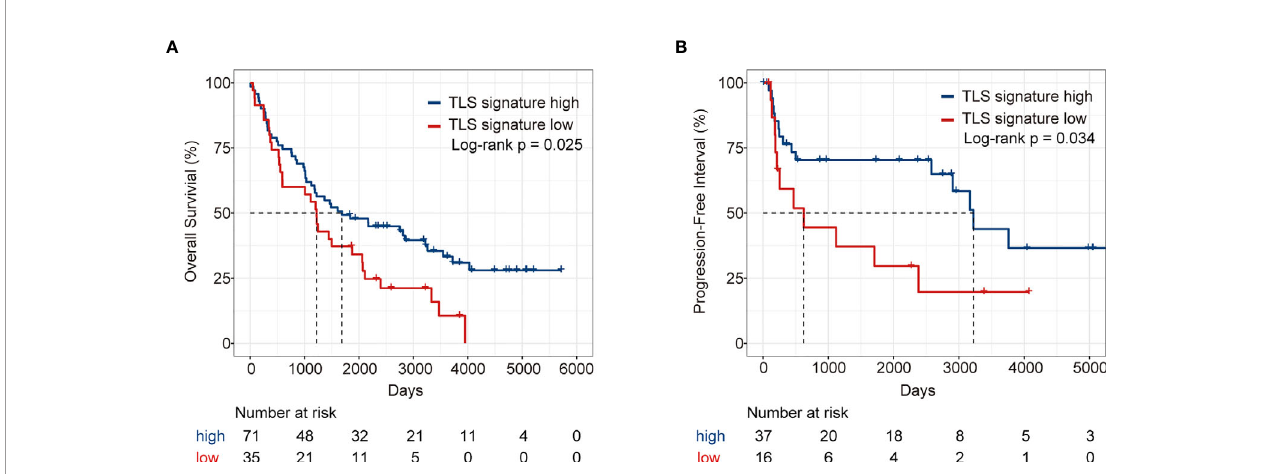
FIGURE 6 | Survival analysis of LUAD patients in GSE37745 dataset between the TLS signature high and low groups. (A) Kaplan – Meier plots of overall survival difference between tumors with TLS high (n = 71) and low groups (n = 35) in LUAD; (B) Kaplan – Meier plots of progression free survival difference between tumors with TLS signature high (n = 37) and low groups (n = 16) in